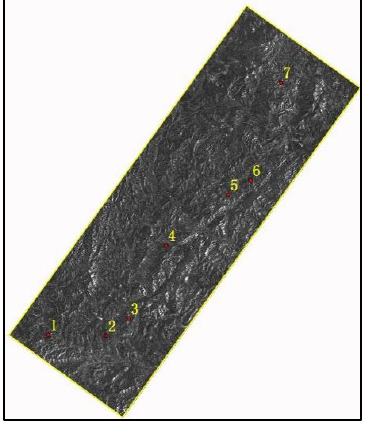
Figure8. The location of deformation